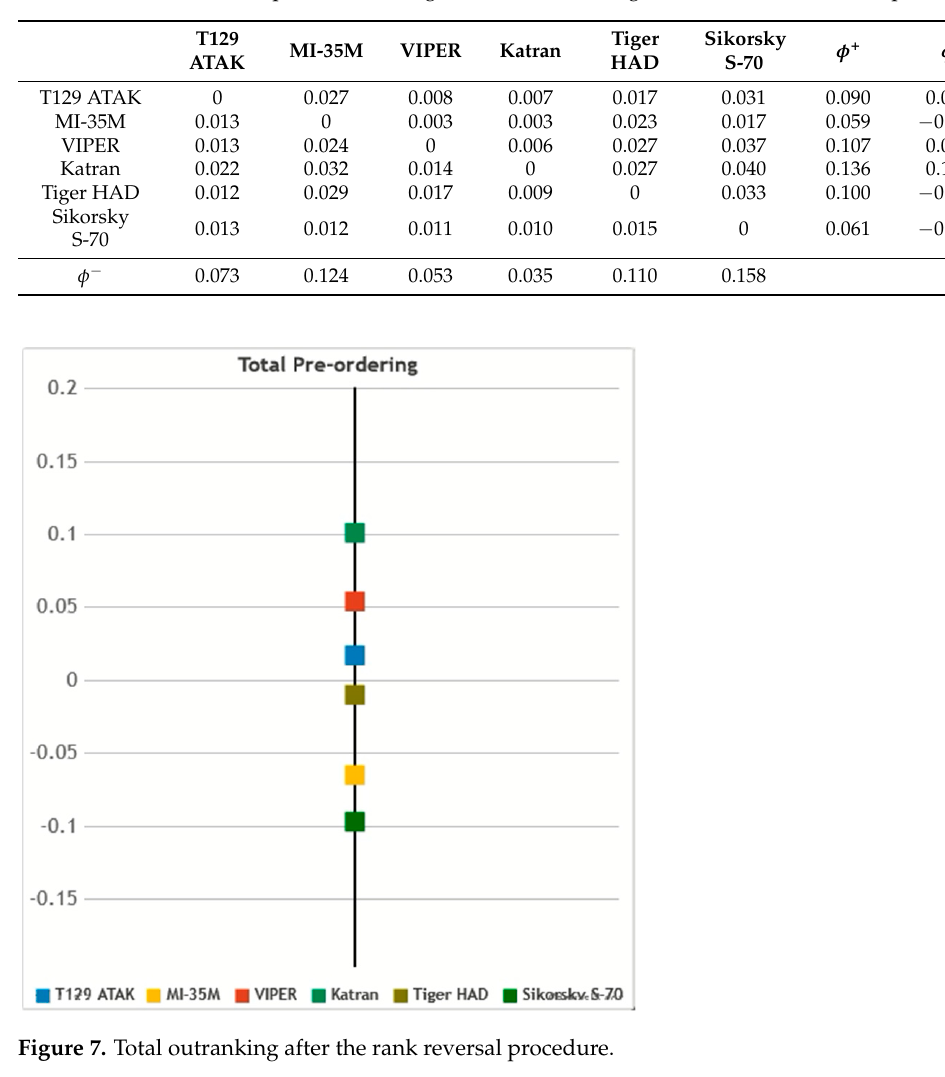
Table 16. Global Index of preference along with the outranking flows after rank reversal procedure.